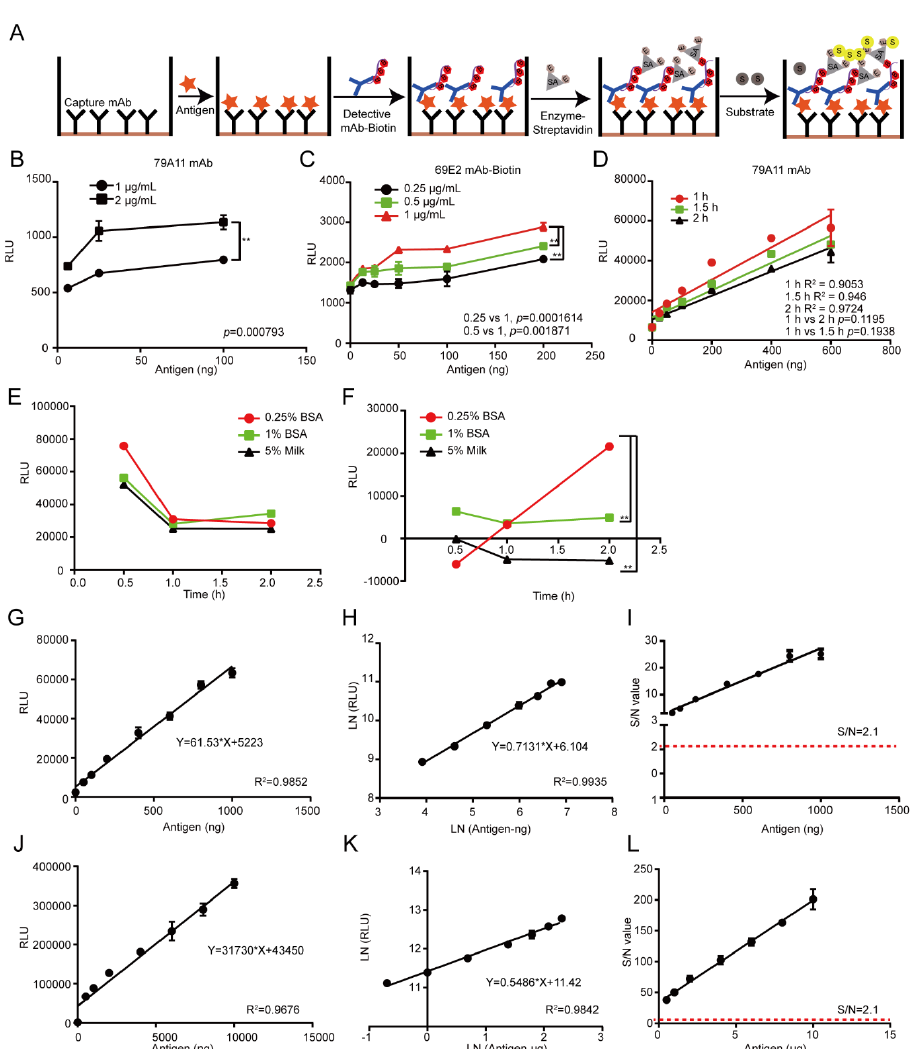
Figure 6. Establishment of a chemiluminescence immunoassay based on the LSAB-ELISA method and luminol detection system for quantitative detection of the HPV16 E7-HIS fusion oncogenic protein. ( A ) The principle diagram of the biotin-streptavidin double-antibody sandwich ELISA (BA-ELISA). The red pentagram represents an antigen; the black “Y” represents a capture antibody; the blue “Y” represents a detecting antibody; B represents an biotin; SA represents a streptavidin; S represents a substrate (lumonol) and E represents an HRP enzyme. ( B ) The optimal concentration of the capture antibody 79A11. ( C ) The optimized reaction concentration of the detection antibody Biotin-69E2. ( D ) The optimized reaction time between the antigen HPV16 E7 protein and the capture antibody. ( E ) The background of the three blocking agents at three time points. ( F ) Signal diagrams at three time points for the three blocking agents. ( G – I ) The straight-line fitting, double-log fitting, and S / N ratio of the antigen HPV16 E7-HIS oncoprotein at the ng-grade equal-difference dilution method. ( J – L ) The straight-line fitting, double-logarithmic fitting, and S / N ratio plots of the HPV16 E7-HIS recombinant oncoprotein at the µ g-grade equal-di ff erence dilution method. LSAB, labeled streptavidin-biotin. RLU, relative light